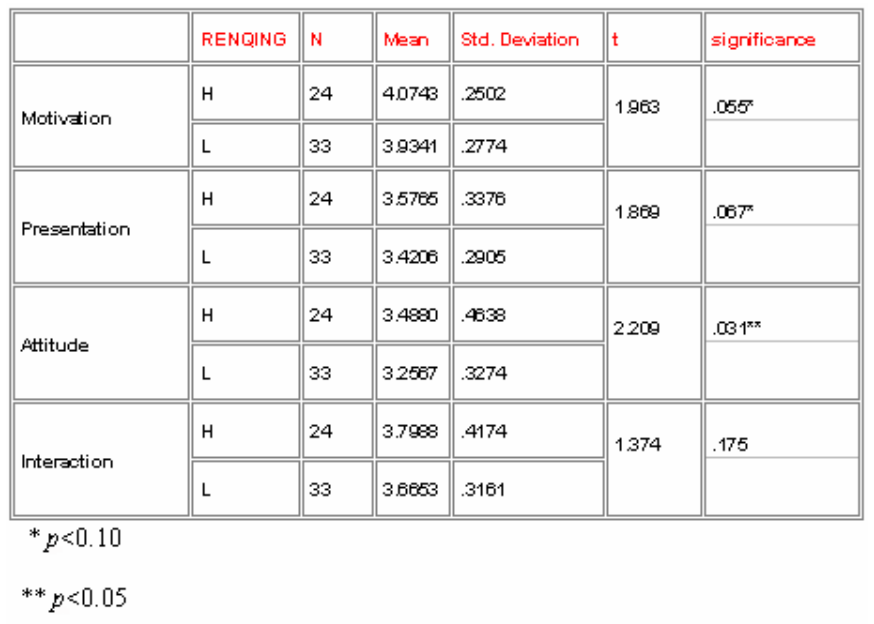
the Four Teaching Dimensions